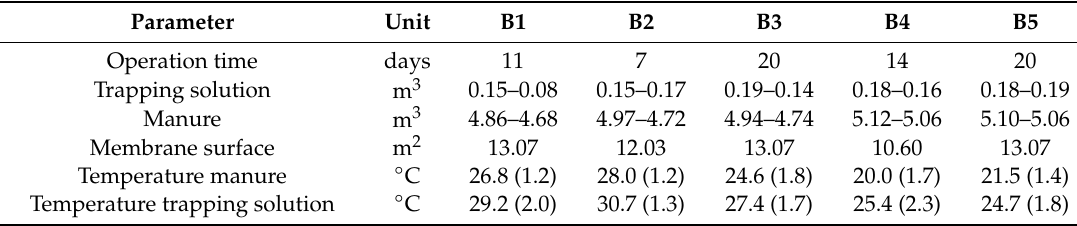
Table 2. Operational parameters during the pilot plant operation. Temperature values are averages (SD) for hourly data collected during each experimental